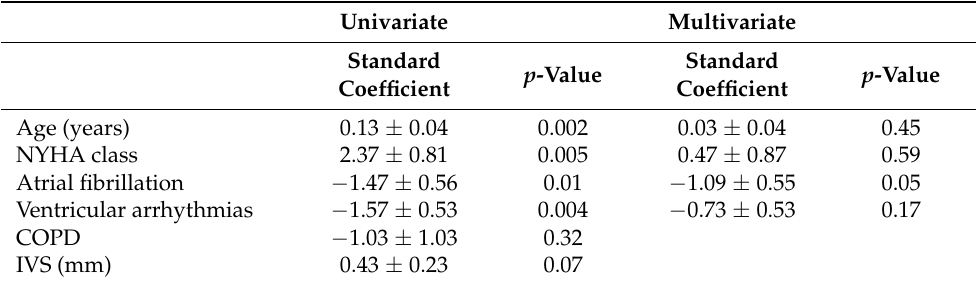
Table 4. Uni- and multivariate linear regression models for